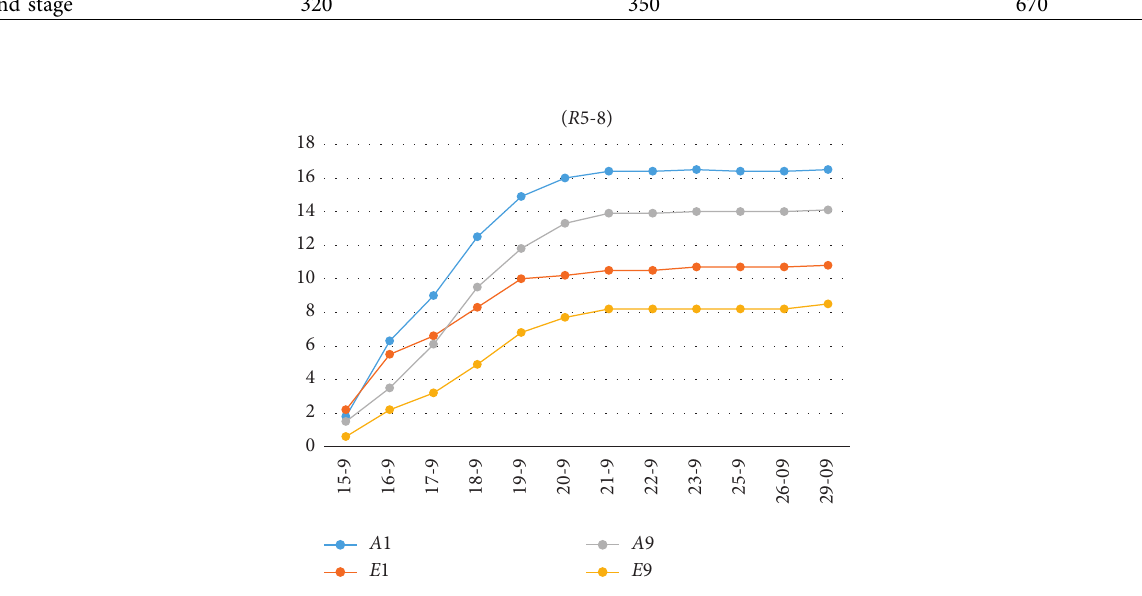
Figure 28: Caisson cumulative meeting on different monitoring days in